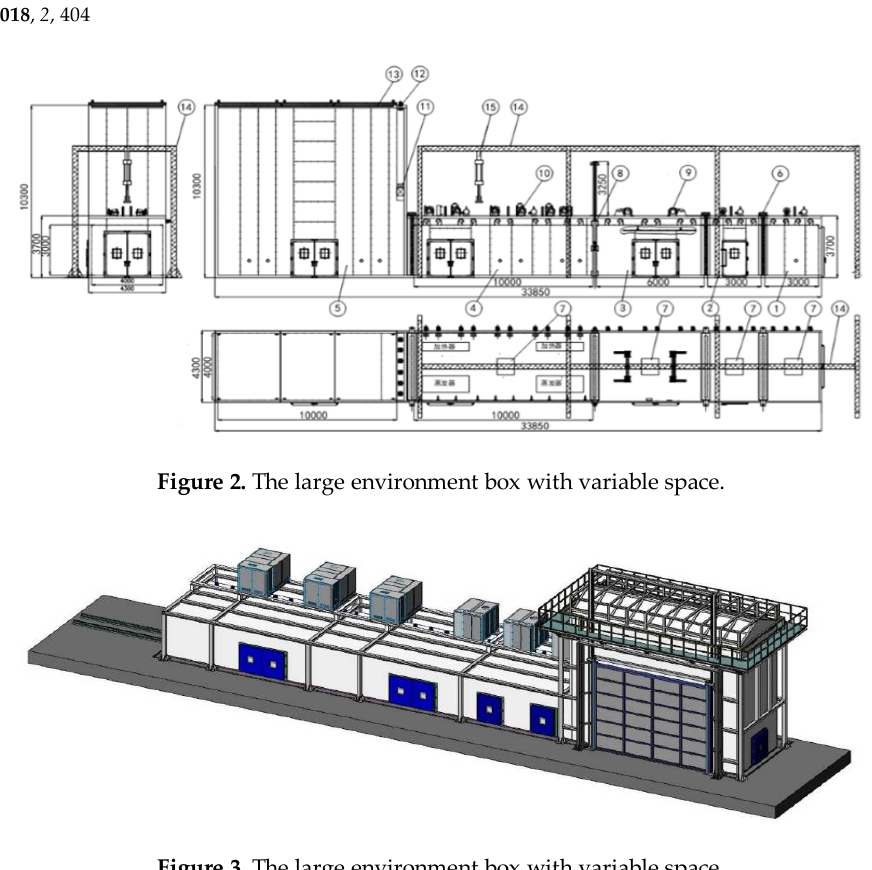
Figure 3. The large environment box with variable space.